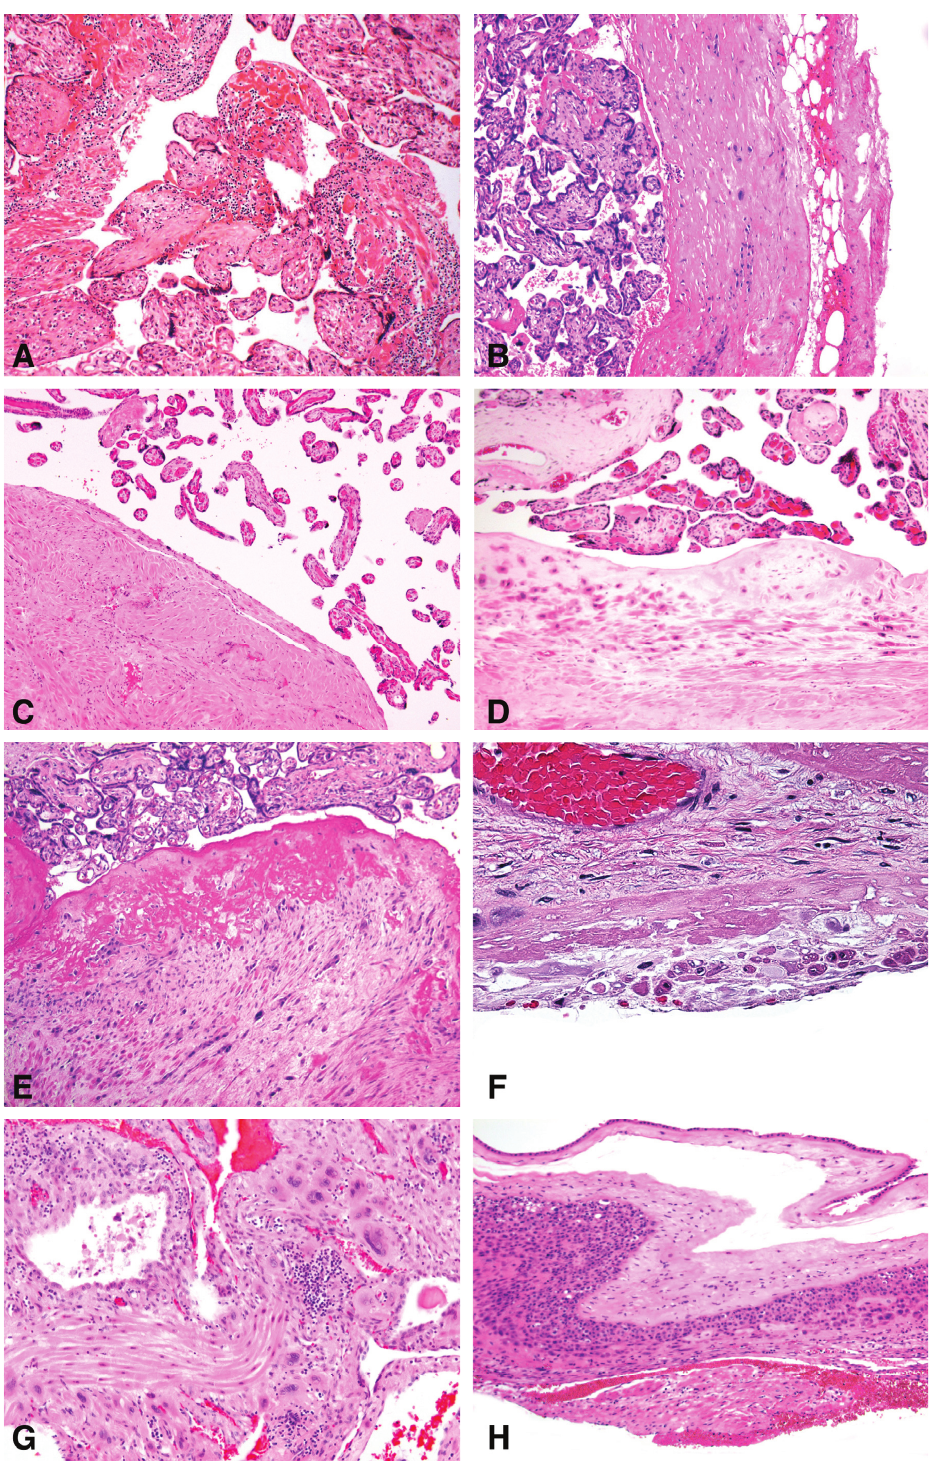
Figure 1: Placenta creta spectrum (haematoxylin and eosin, original objective magnifications are given in parentheses). (a) Placenta increta: myometrial fibers are intermingled with chorionic villi (20x). (b) Placenta percreta: placental tissue is separated from the subperitoneal fat only by fibrous tissue (10x). (c) Symptomatic placenta accreta: myometrial tissue in direct contact with the intervillous space (10x). (d) Occult placenta accreta: extravillous trophoblasts with underlying myometrial fibers in direct contact with the intervillous space (10x). (e) Occult placenta accreta: Rohr fibrinoid with an underlying mix of myometrial fibers and extravillous trophoblast (10x). (f) Basal plate myometrial fibers: Rohr fibrinoid with underlying decidua, Nitabush fibrinoid, and myometrial fibers (40x). (g) Myometrial fibers in a shaved section from a margin of disruption of the maternal floor (20x). (h) Placental membranes with adjacent myometrial fibers (chorion leave accreta)